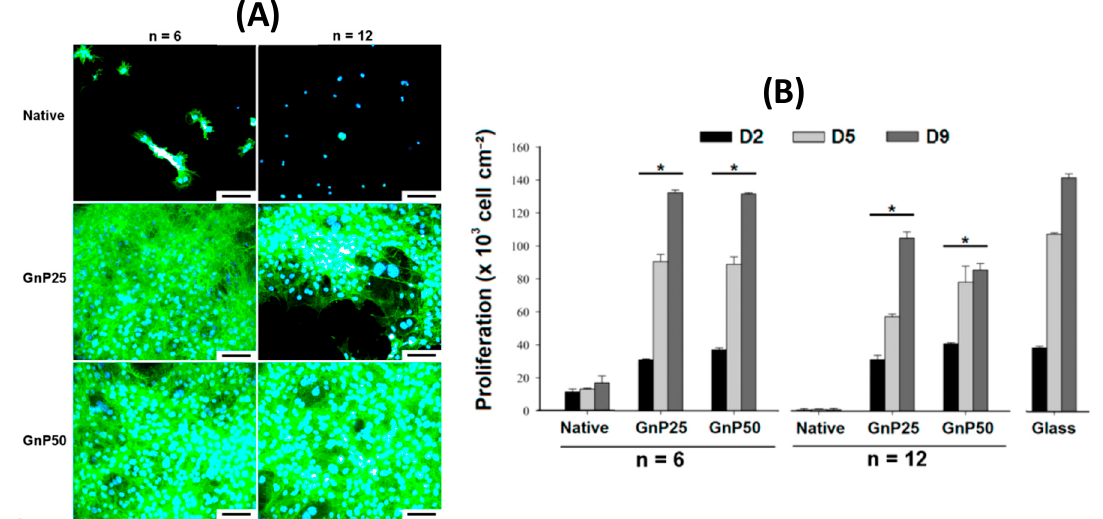
Figure 12. Fluorescence images of MC3T3-E1 cells after 10 days of culture atop native, GnP25- and GnP50-crosslinked PEI / (CS / PLL)n films in standard medium (blue: DAPI-labelled nuclei; green: FITC-labelled actin network) Scale bars are 100 µ m ( A ). Proliferation of cells upon the various films, as measured by Alamar Blue assays, after 2, 5, and 9 days (D2, D5, D9, respectively) of culture ( B ). * represents p < 0.05 with respect to the corresponding native films. Figure taken from reference [81], Copyright © 2020 American Chemical